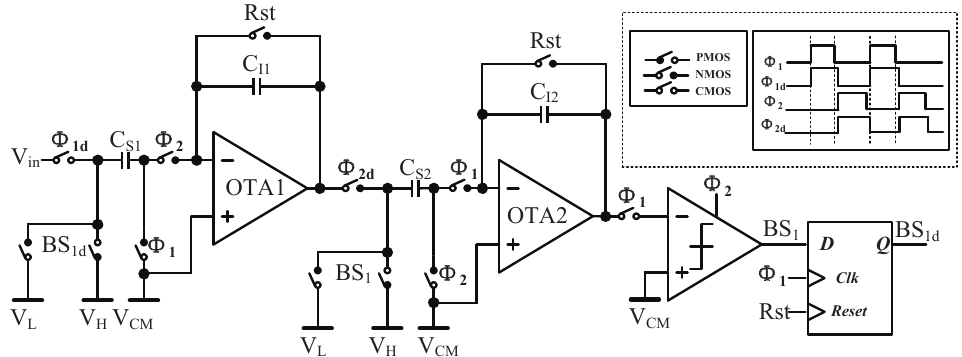
Figure 7. Circuit diagram of the second-order incremental delta-sigma